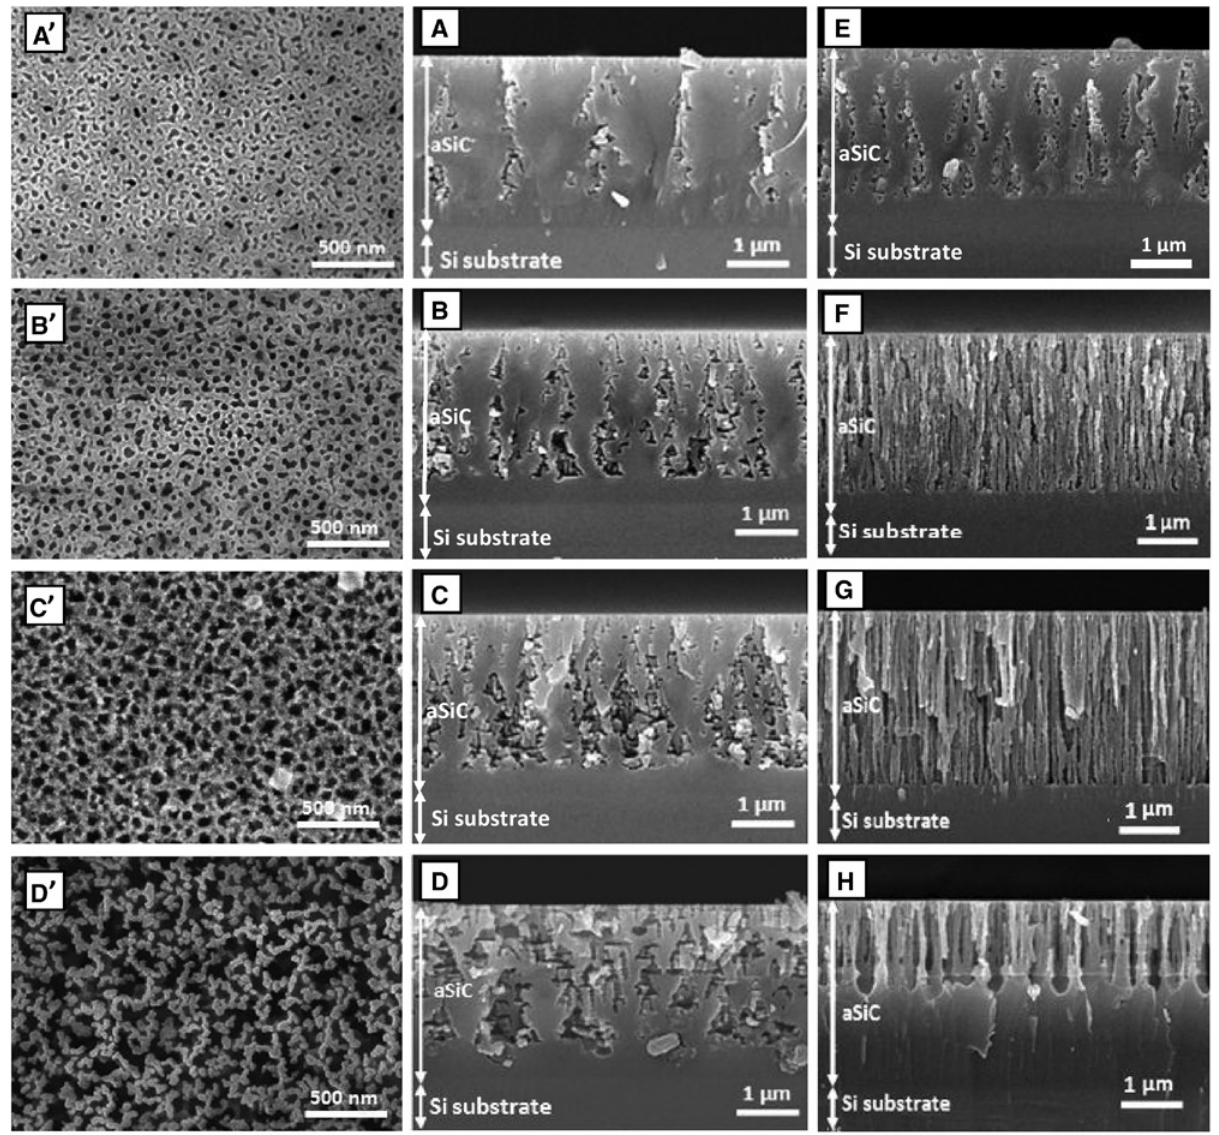
Figure 1: SEM images showing the plan view (left column) and the cross-sectional view (middle column) of four a-SiC samples that have been anodically etched for 30 min in 0.5% HF/EG electrolyte with a current density of (A ′ , A) 0.5, (B ′ , B) 1.0, (C ′ , C) 2.0, and (D ′ , D) 2.5 mA/cm 2 , as well as the cross-sectional view (right column) of four a-SiC samples that have been anodically etched for 50 min in 0.5% HF/H with a current density of (E) 0.5, (F) 1.0, (G) 2.0, and (H) 2.5 mA/cm 2